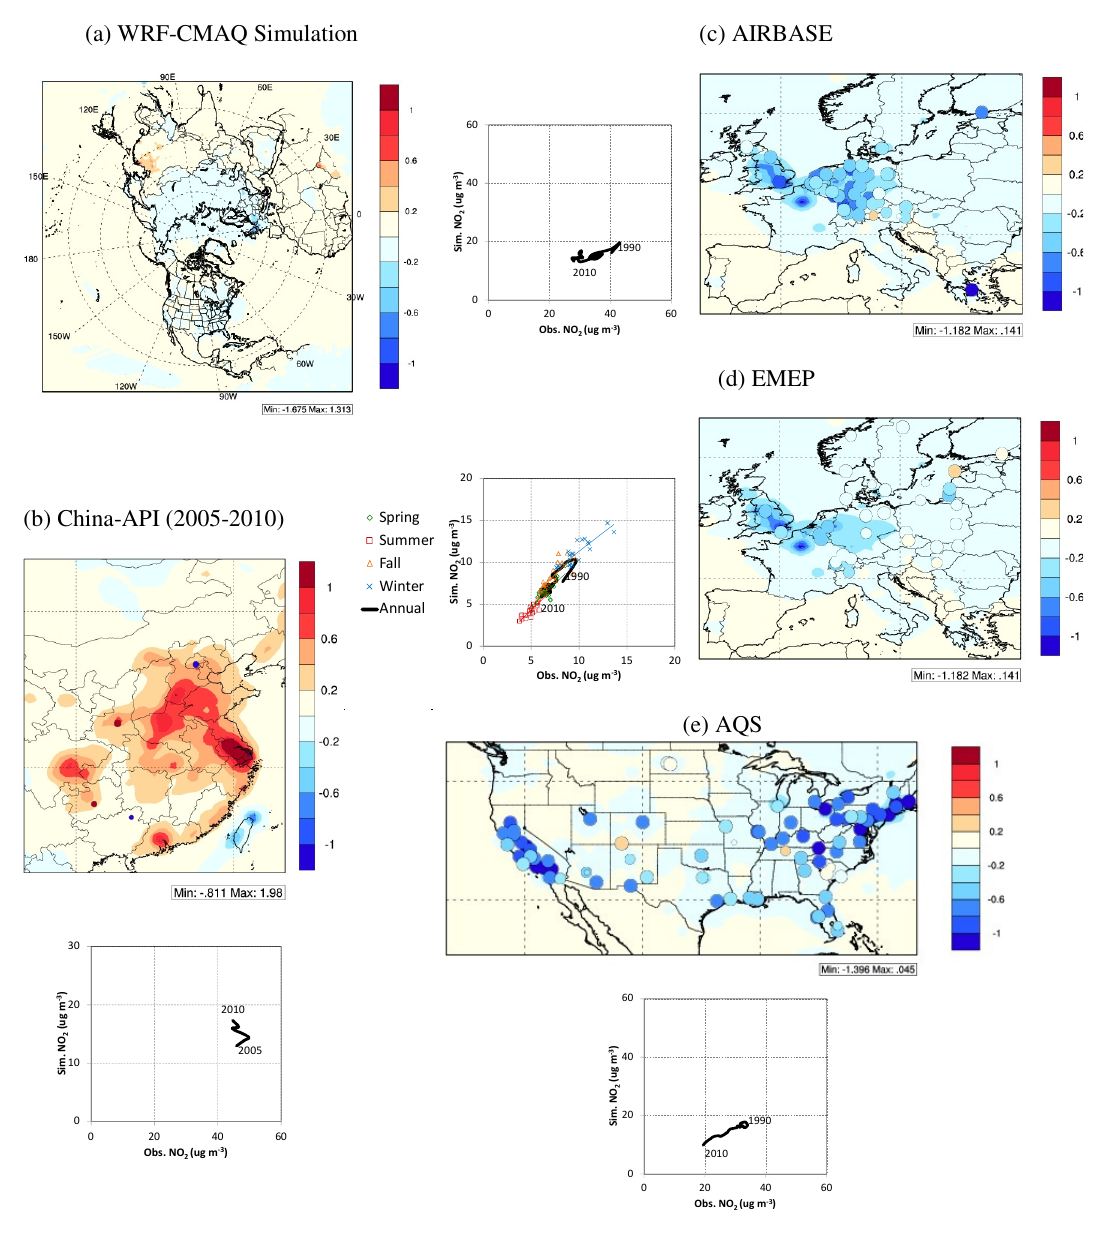
Figure 4. Same as Fig. 3 for NO 2 .